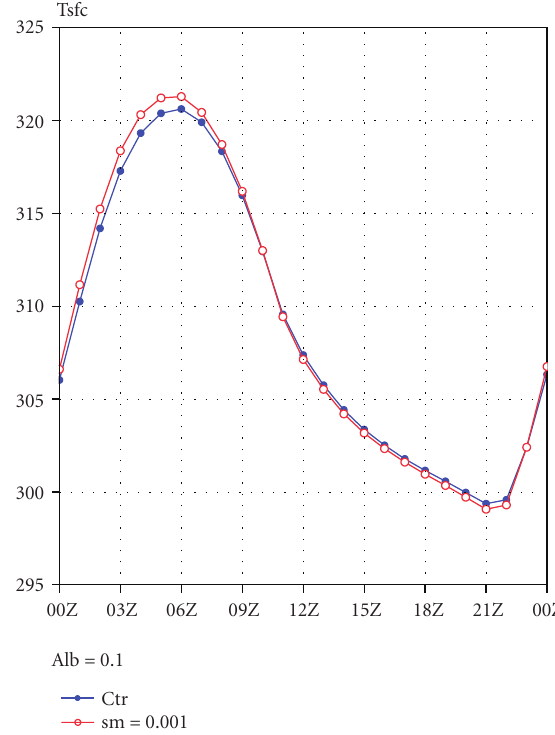
Figure 12: Sensitivity study for soil moisture on surface skin temperature. In the control run, initial soil moisture is interpolated from NCEP FNL analysis, and in the sensitivity run, soil moisture in Beijing is set as a small value (0.001 m 3 /m 3 ). The surface albedo is set as 0.10. The experiment area is over Beijing (39.7–40.1 ◦ N, 116.1– 116.7 ◦ E). The unit of the y -axis is Kelvin